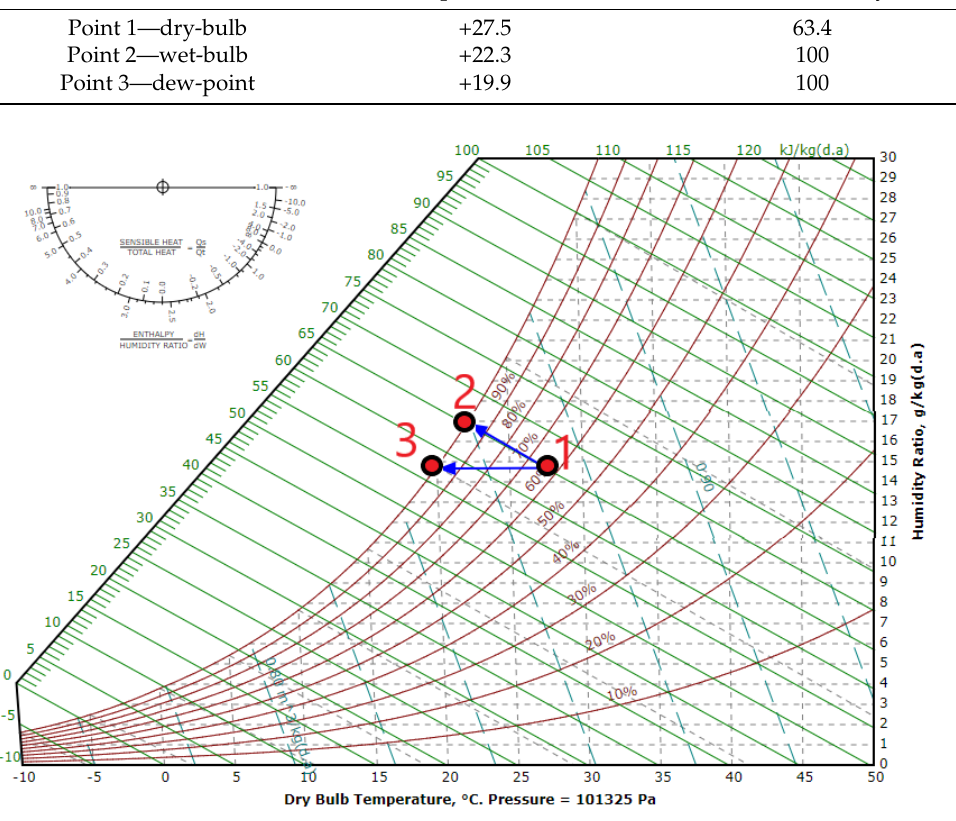
Figure 3. Representation of two processes for Warsaw climatic data [13]: 1–2—DEC; 1–3—IEC [14].